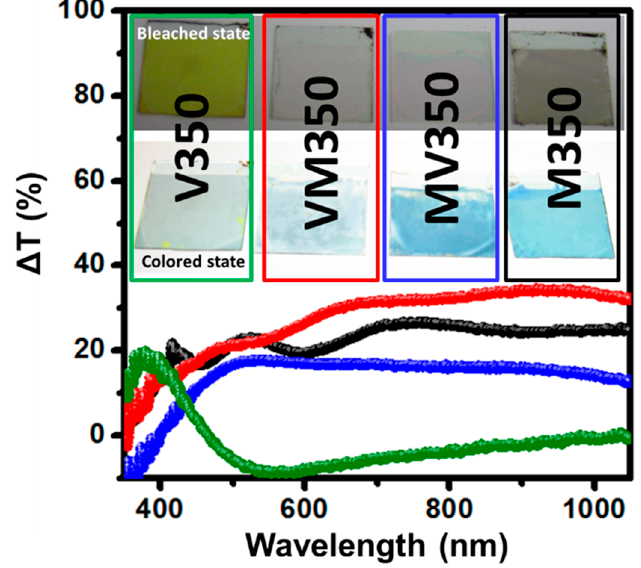
Figure 6. Transmittance changes ( ∆ T ) of MoO 3 / V 2 O 5 hybrid nanobilayers heated at 350 ◦ C for 2 h in air.